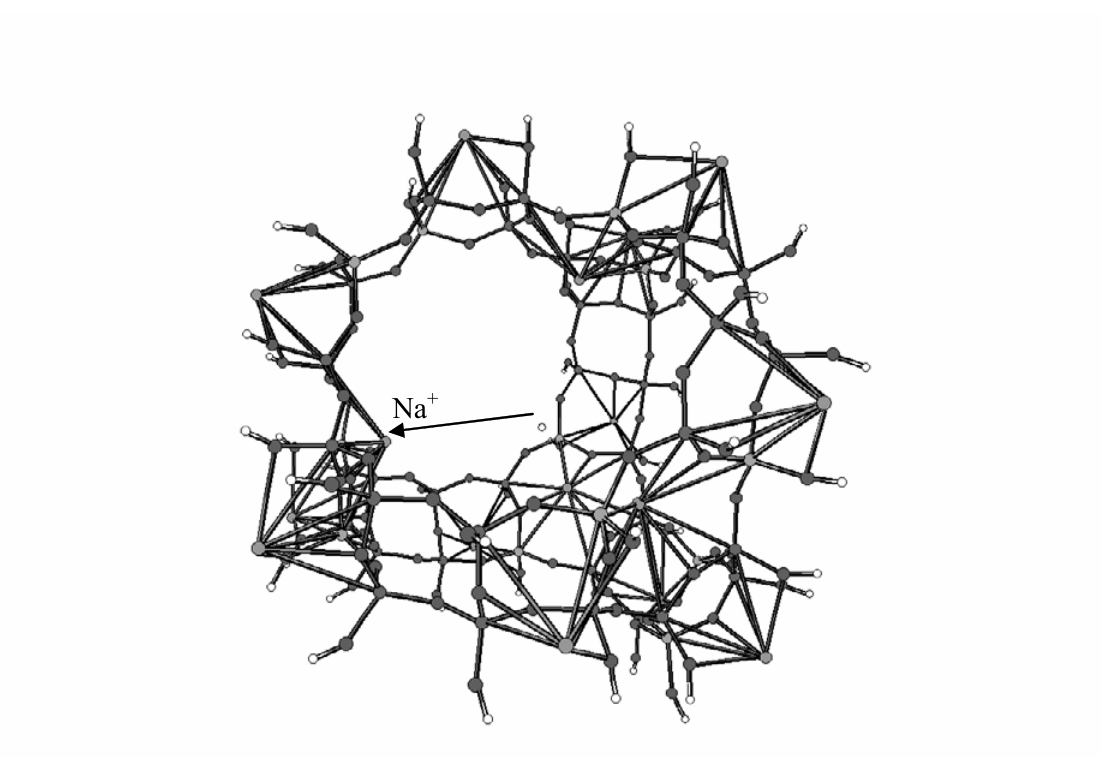
Figure 15 : Cluster used to model the large cage of faujasite Y (Reprinted with permission by J. Wiley - Reference